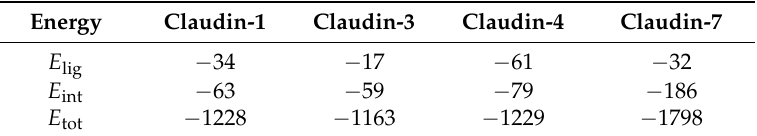
Table 3. Docking energy components of PN159 to selected human claudin monomers. E tot , total energy; E lig , ligand energy; E int , interaction energy.